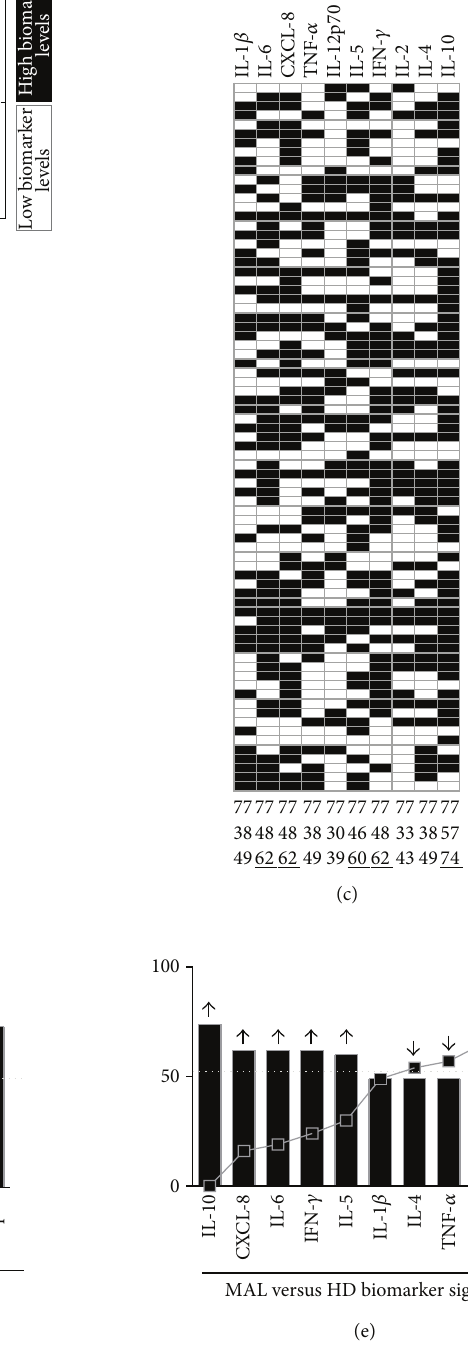
Figure 3: Overall signature of high biomarker producers triggered by P. vivax infection. (a) Representative scheme for global median cut-off calculation, using serum TNF- 𝛼 levels as an example to categorize the individuals as those presenting “low” (white boxes) or “high” (black boxes) biomarker levels. Gray-scale diagrams were used to compute the frequency of individuals with high biomarker levels into healthy donors—HD group (b), and P. vivax -infected patients—MAL group (c). Bars graphs represent the proportions of individuals with high biomarker levels of HD and MAL groups (d and e, resp.). The HD ascendant biomarker profile was converted in a reference line overlaid for comparative analysis with MAL. Relevant differences were considered when the frequency of individuals with high biomarker levels in the MAL groups shifted to a distinct 50th percentile side (dotted